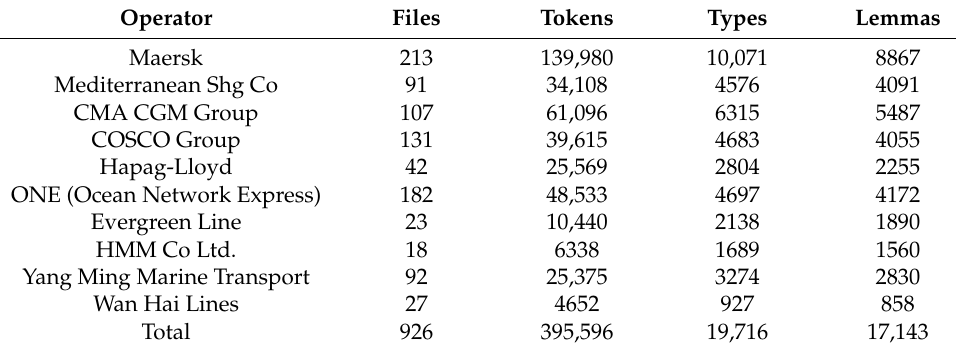
Table 2. The specific descriptions of the ten corpora.